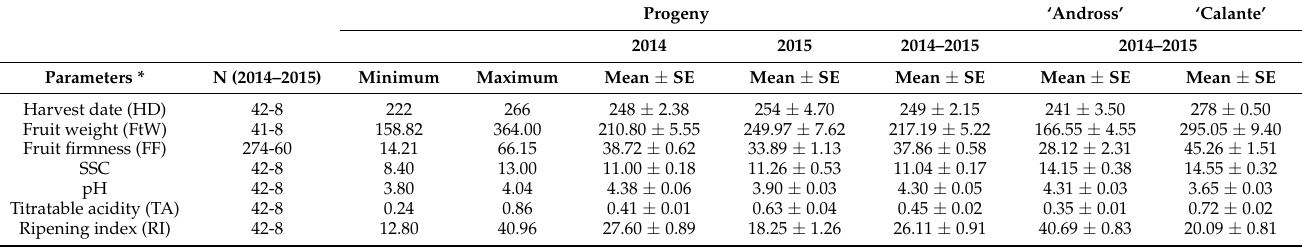
Units and abbreviations: Fruit firmness (Newton, N); Soluble solids content (SSC, ◦ Brix); Titratable acidity (%); Ripening index (SSC/TA); SE = Standard error;. * Statistics were not conducted here between years because the number of samples were biased between years (2014 vs. 2015).